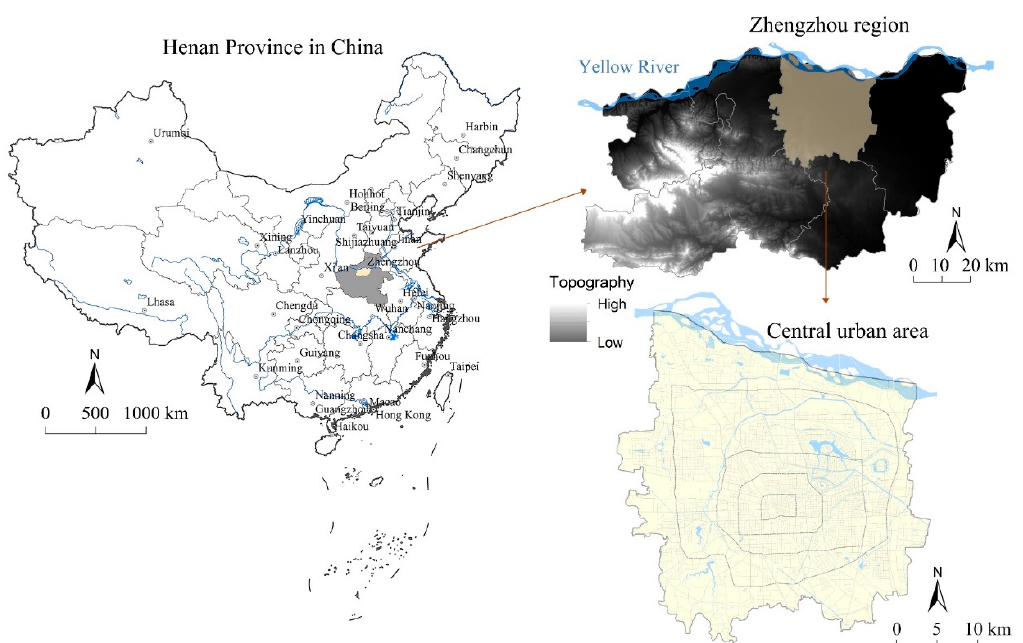
Figure 2. Geography, topography and the five rings of development in Zhengzhou, Henan Province.